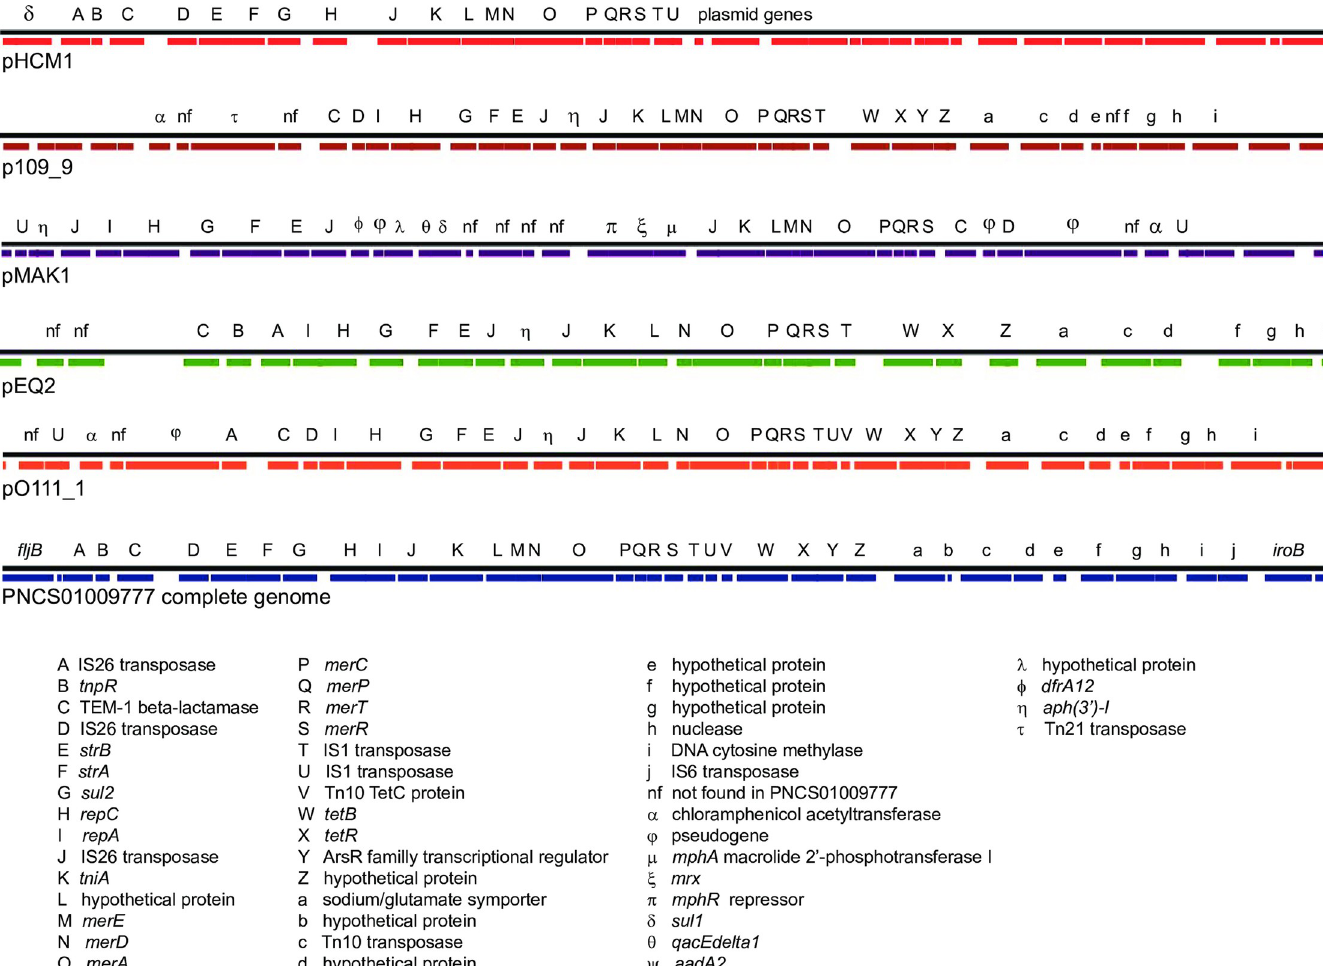
Fig 7. Synteny and variability of the MREL in previously characterized plasmids compared with the MREL of reference isolate PNCS009777. This figure was constructed the same way as Fig 4.